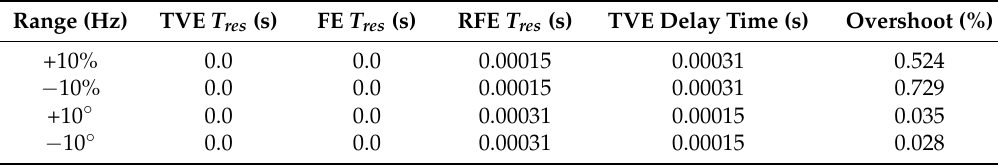
Table 1. Step changes in magnitude and phase angle test